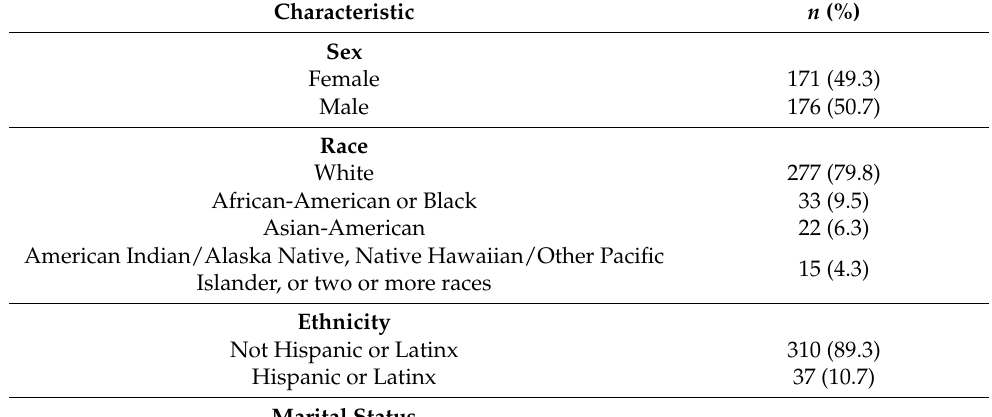
Table 1. Characteristics of golfers.